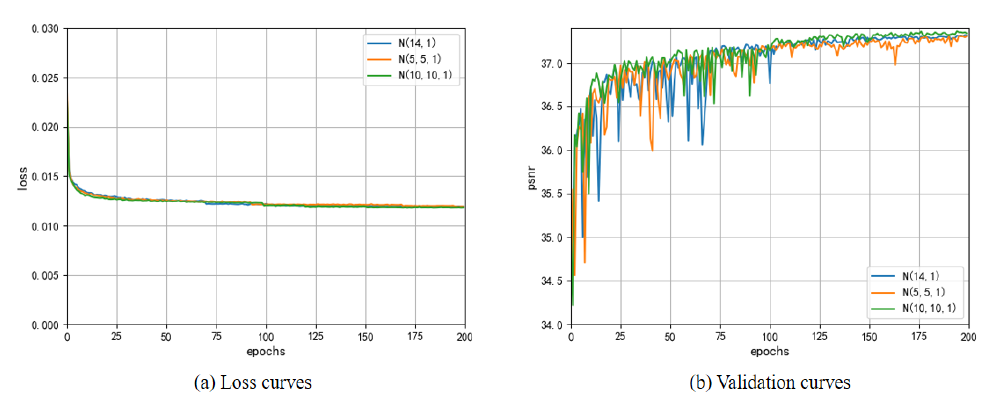
Figure 4. Training curves for N = (12,1), N = (5,5,1) and N = (10,10,1).